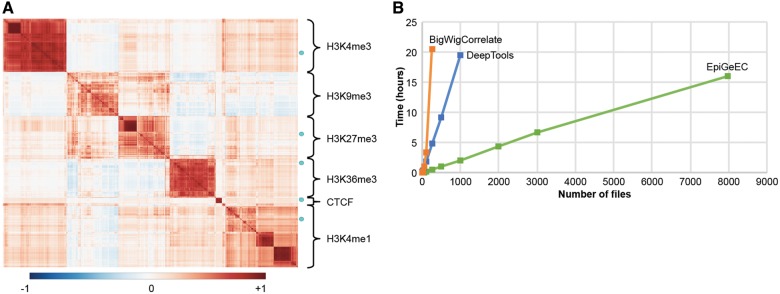
(A) Heatmap representation adapted from the PDF report (Supplementary Fig. S2), showing the annotated correlation matrix between 10 user-provided datasets (cyan dots) mapped onto hg19 (accession GSE50893) and 3101 public pre-computed datasets from the IHEC_hg19_2017-10 freeze. This matrix was generated in <10 min. (B) Time spent by three tools generating correlation matrices of various sizes, starting directly from the bigWig (no pre-computation)